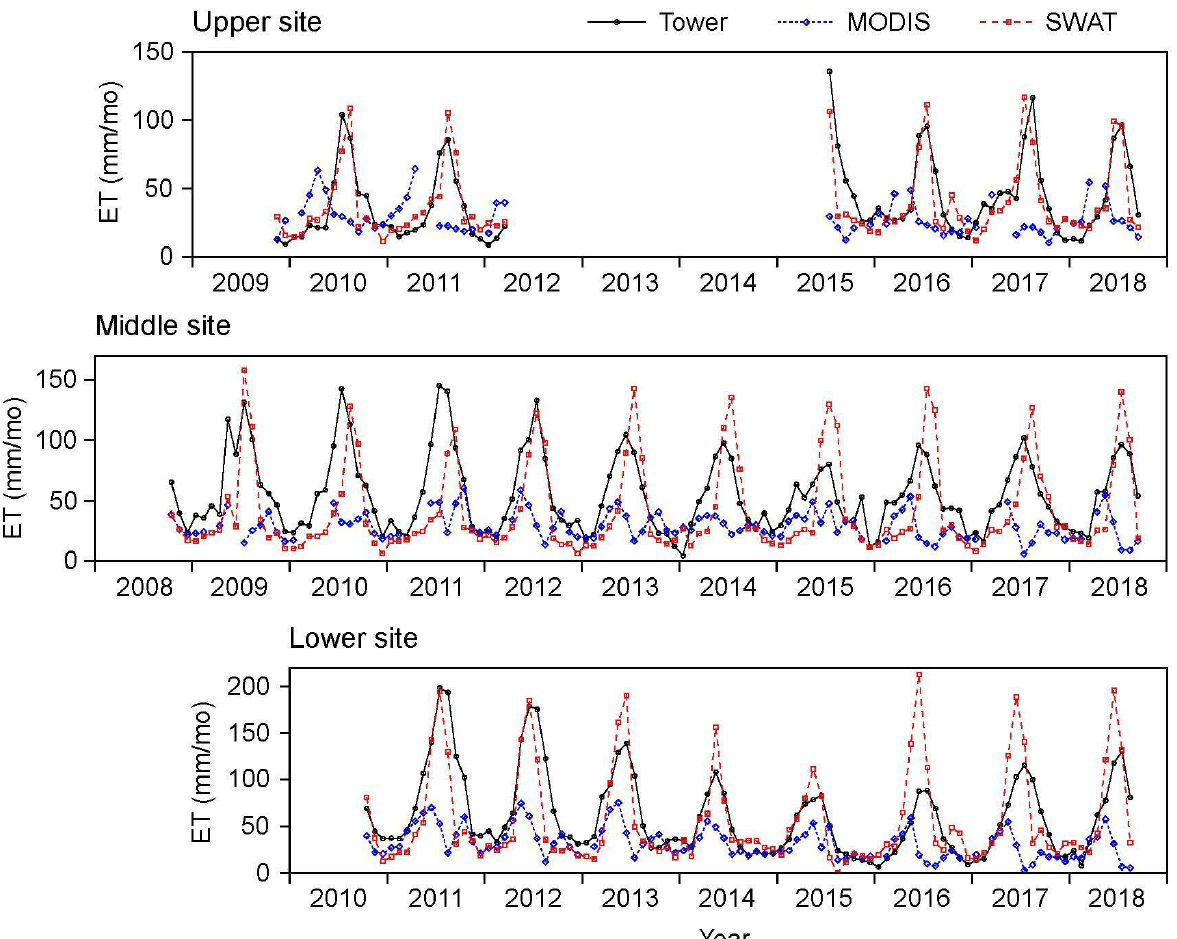
Figure 4. Monthly ET from flux towers, MODIS, and SWAT at three sites in upper Kings River watershed.